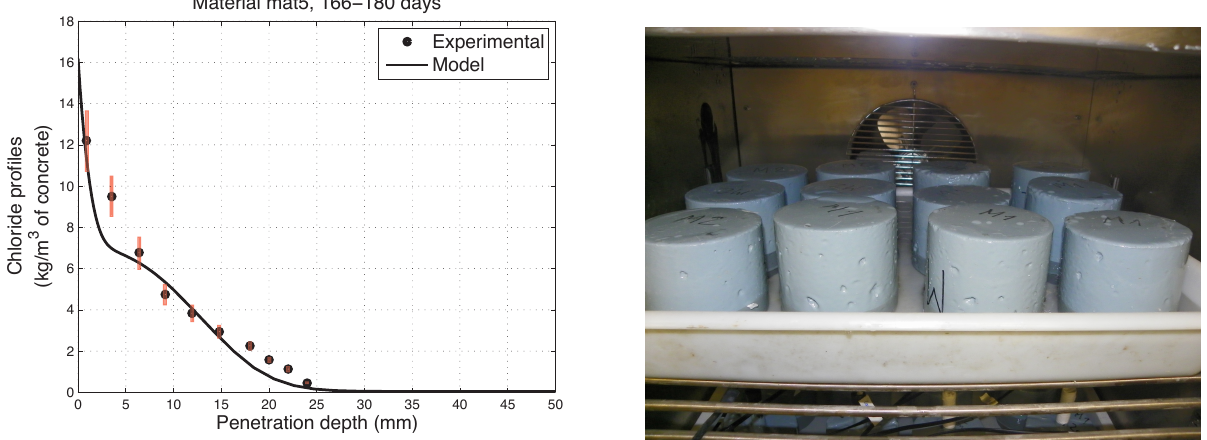
Figure 7. Left : experimental versus numerical solution for material mat5 and environment 5 (166–180 days). Right : concrete samples exposed to